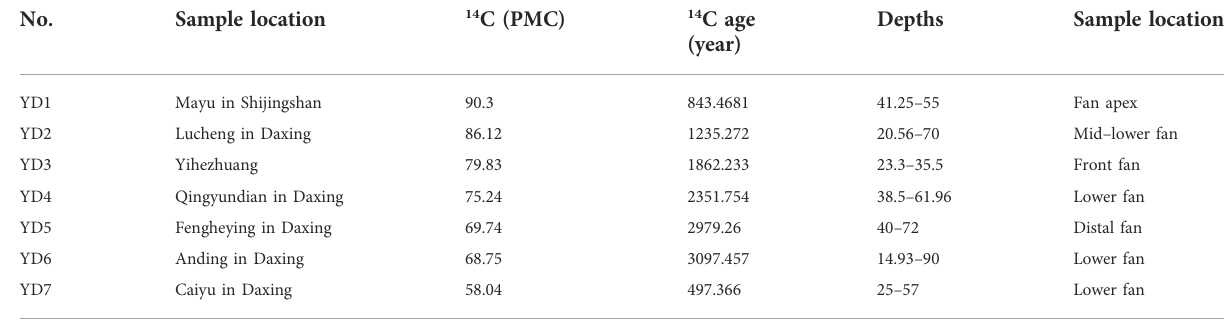
TABLE 8 Groundwater age-dating data ( 14 C).